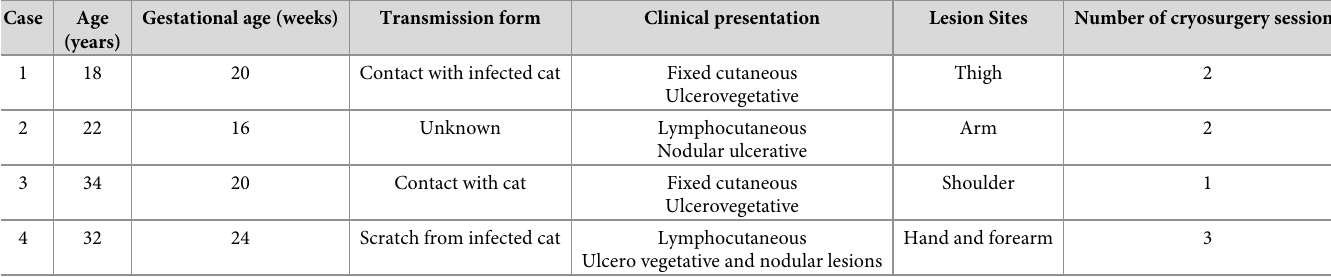
Table 1. Epidemiological, clinical and therapeutic aspects of four pregnant patients with sporotrichosis treated with cryosurgery.